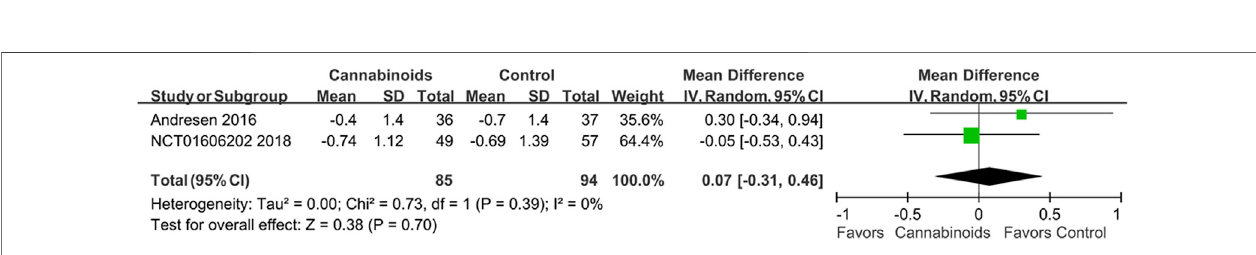
Frontiers in Pharmacology |